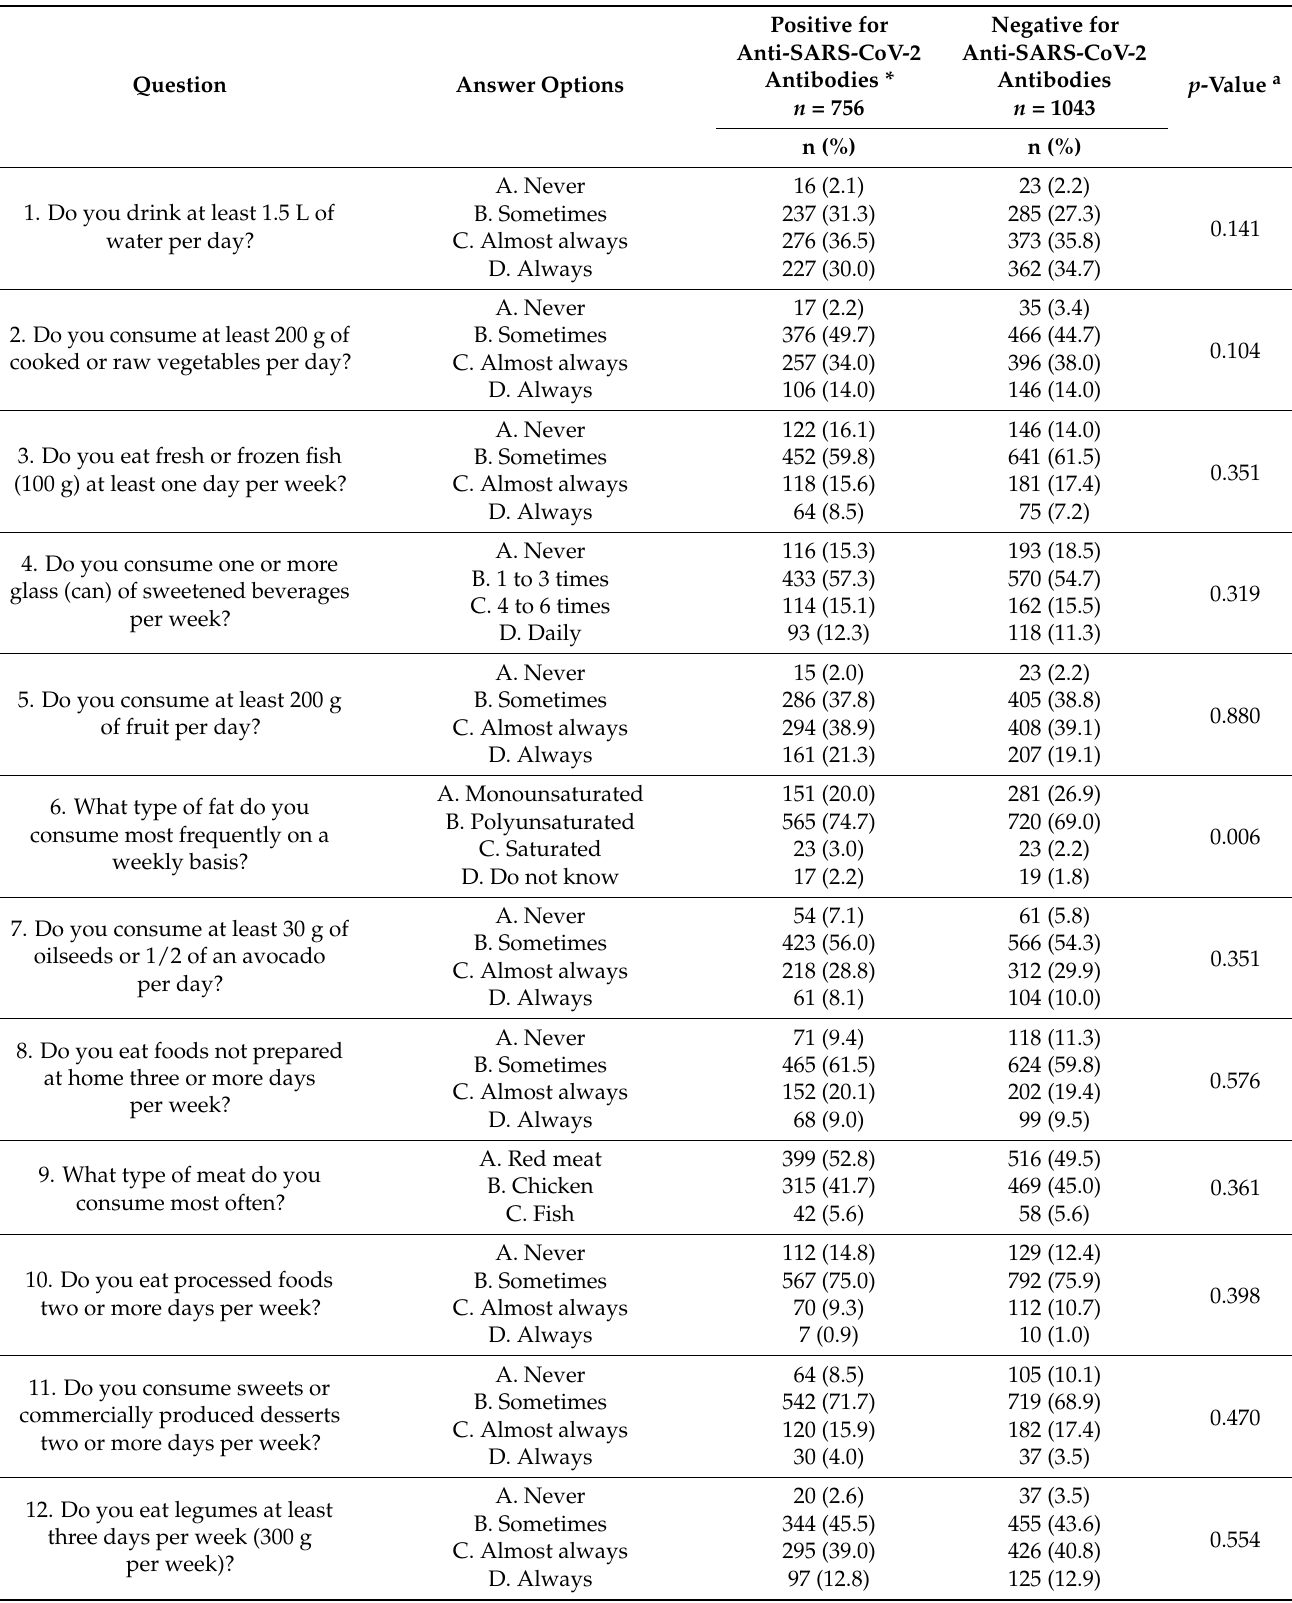
Table 4. Food intake quality in individuals negative or positive to anti-SARS-CoV-2